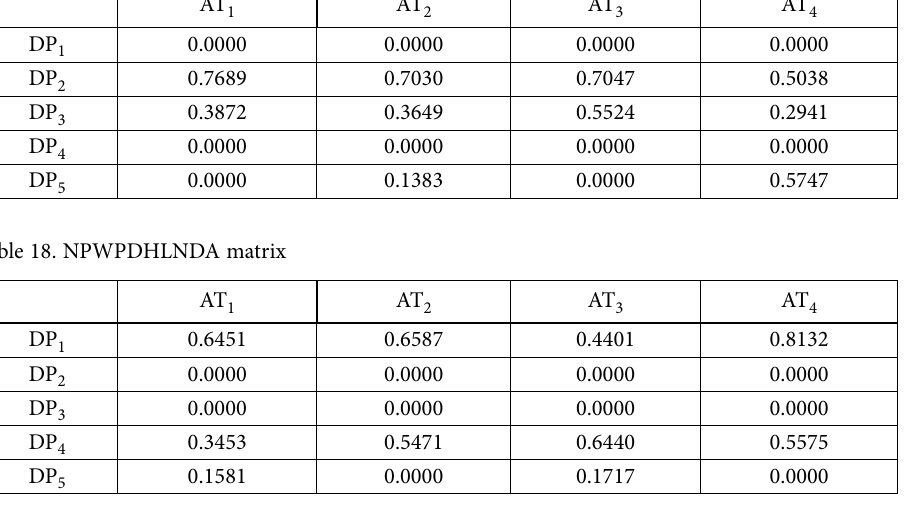
Table 17. The NPWPDHLPDA matrix AT 1 AT 2 AT 3 AT 4 DP 1